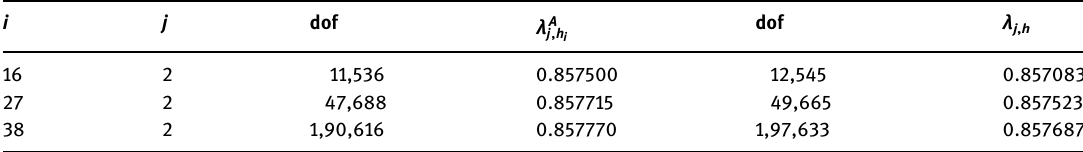
Table 1: The second eigenvalue for ( 2.1 ) – ( 2.2 ) : L - shaped domain ( k = 1, n ( x ) = 4 )